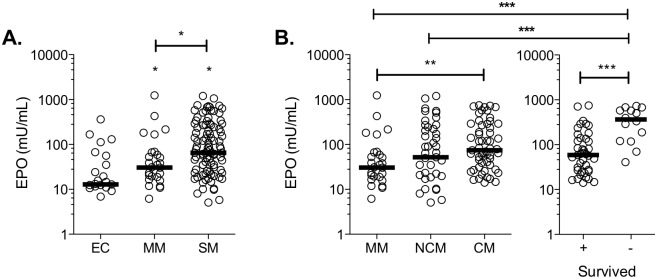
Erythropoietin levels increase during cerebral malaria and with severity of the infection.(A) Erythropoietin (EPO) levels were measured in the plasma of endemic controls (EC), mild malaria (MM) and severe malaria (SM) patients, and (B) in the SM sub-groups of non-cerebral malaria (NCM) and cerebral malaria (CM). (C) EPO levels were compared between CM patients who survived and those who did not. Significant differences with the EC group or between selected groups are indicated as the following: *p ≤ 0.05; **p ≤ 0.01; ***p ≤ 0.001.